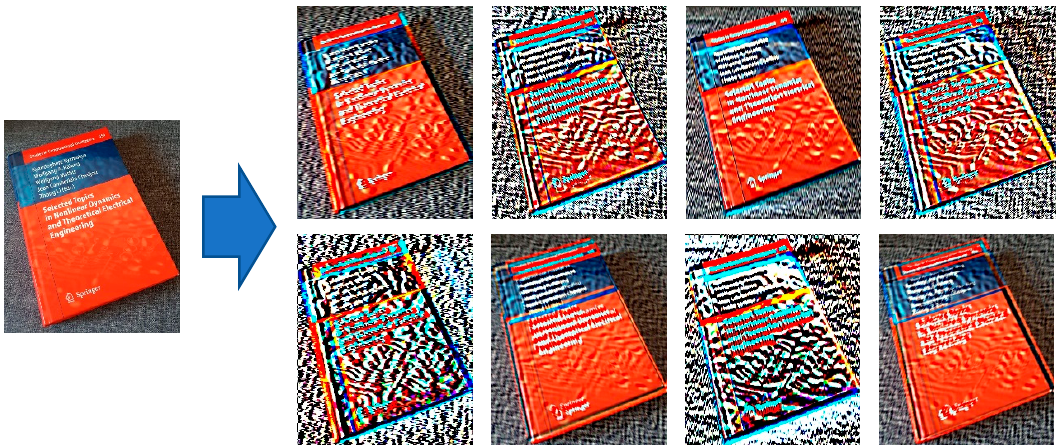
Figure 9. Example of Gabor filter outputs while playing with parameters, as one can see different output patterns are created. From left to right, the theta(rotation) is changed from 0 to 135 degrees. From top to down, the sigma is changed from 16 to 40. The kernel size which is used in this experiment is 40. (Source of input image: own images).